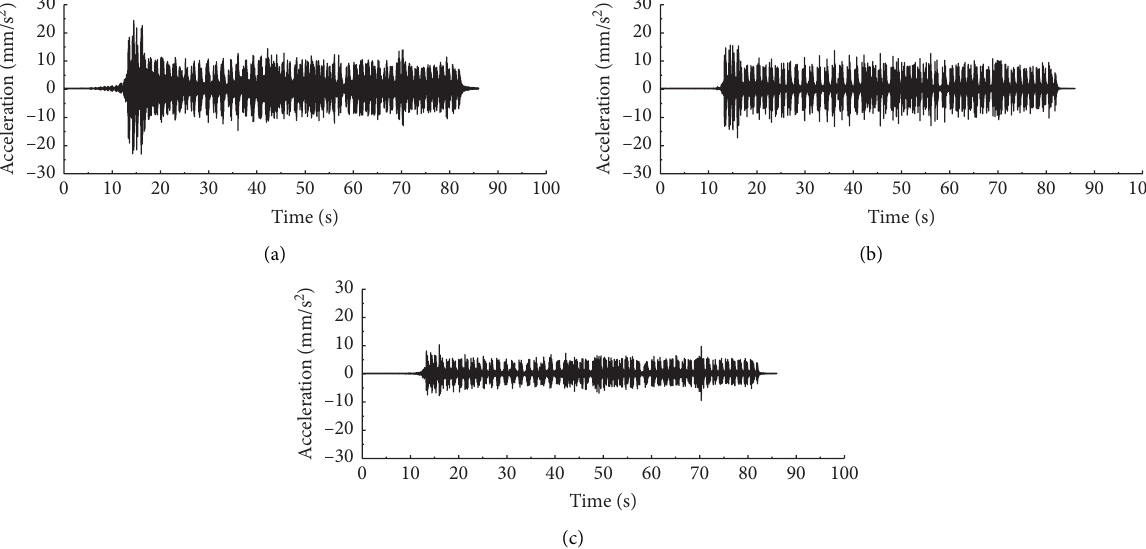
Figure 8: Time-domain curves of vibration acceleration of C1 measuring point before subgrade reinforcement-truck in different directions: (a) Z direction. (b) Y direction. (c) X